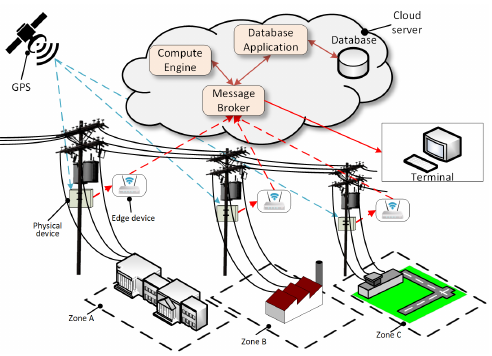
Figure 1. Internet of things (IoT) framework for fault identification and localization application utilizing virtualization and edge intelligence features of